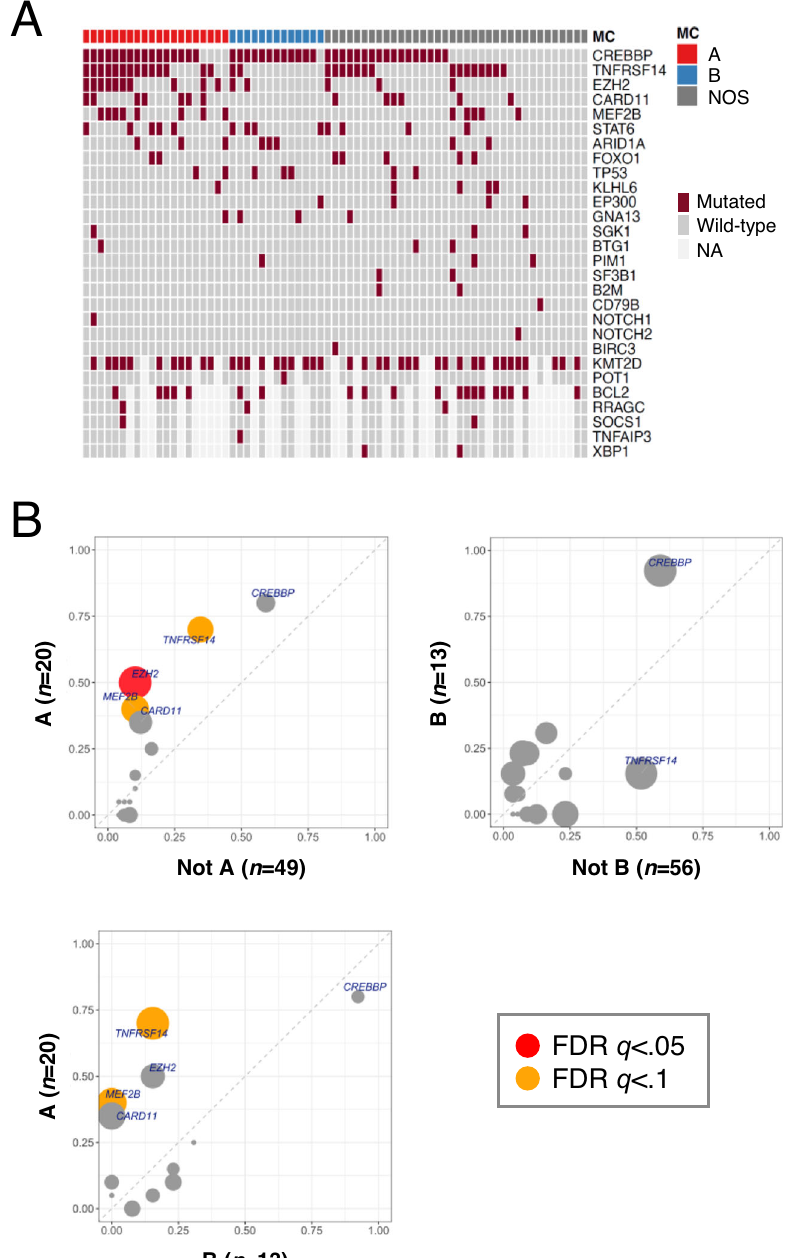
Fig. 6 | FL subtypes show distinct DNA mutation patterns. A DNA co-mutation plot from targeted sequencing of 69 FL samples. Tumor type is de fi ned as >50% MC-A or MC-B cells among clonal B-cells, or neither. B Mutation frequency plots FL subtypes and intratumoral entropy de fi ne patients with dis- parate clinical outcomes